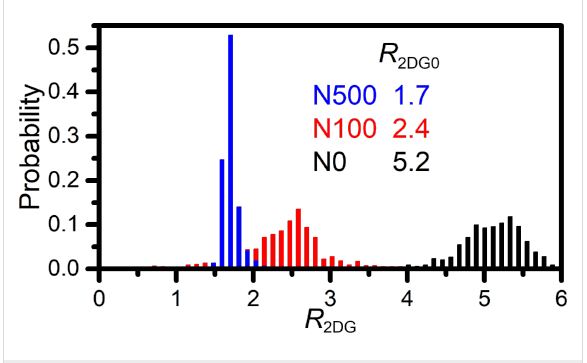
Figure 4: Histograms of intensity ratios between 2D and G bands.